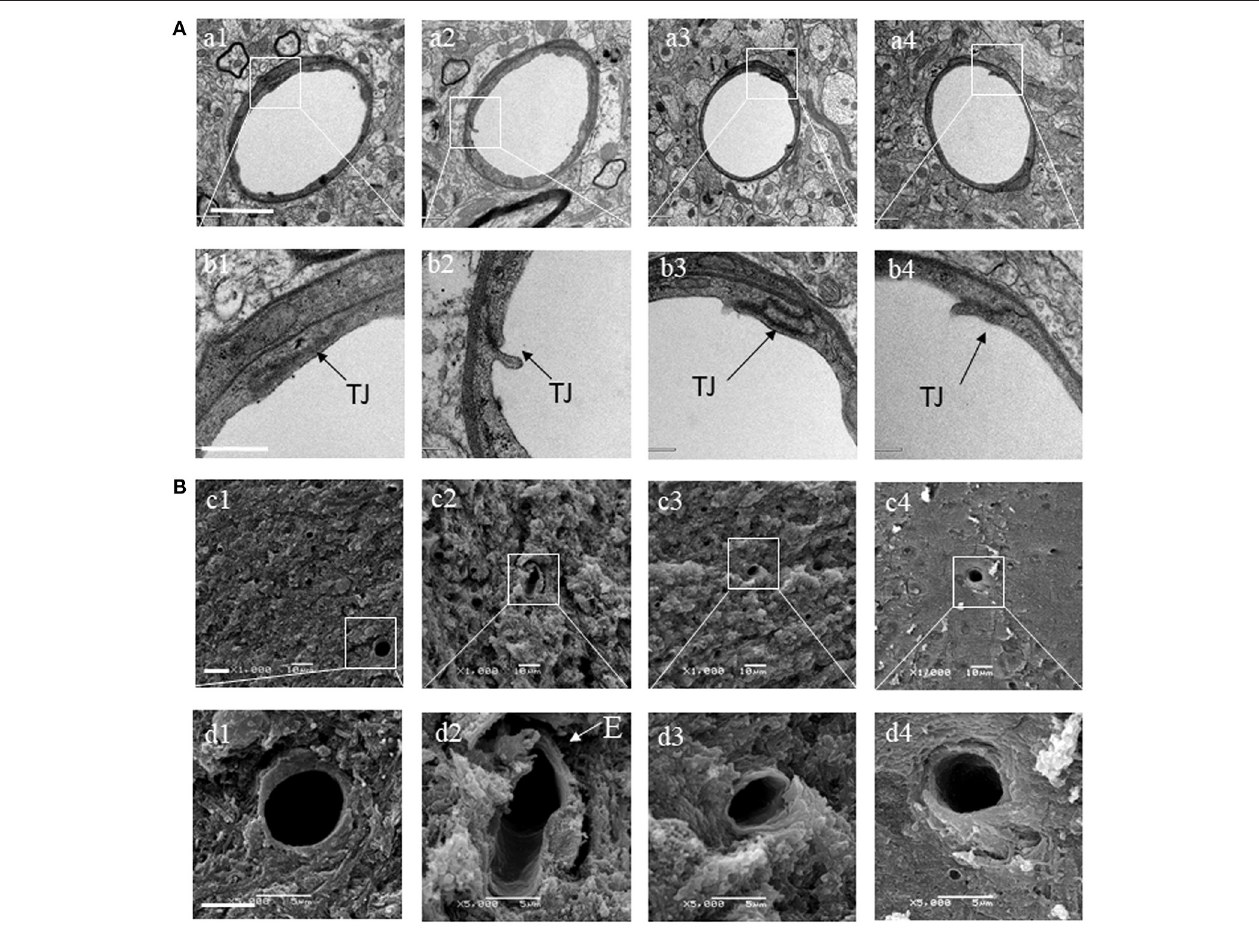
FIGURE 7 | The effect of BSHX on ultrastructure of microvessels in cerebral hippocampal CA1 sector. (A) Representative images of the cerebral hippocampus from different groups detected by TEM (upper two panels). (B) Representative images of the cerebral hippocampus from different groups detected by SEM (lower two panels). Micrographs in b,d are the high magnification of the area inside the boxes in a,b, respectively. a1: C57 group; a2: KKAy group; a3: KKAy + BSHX 1 g/kg group; a4: KKAy + BSHX 2 g/kg. TJ: tight junction. Bar (a1) = 2 µ m; Bar (b1) = 0.5 µ m; Bar (c1) = 1 µ m; Bar (d1) = 5 µ m.